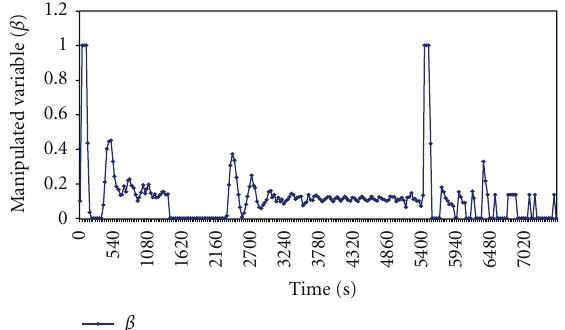
Figure 7: Evolution of thermal flux and limits thermal flux, K = 0.5, K r = 1.